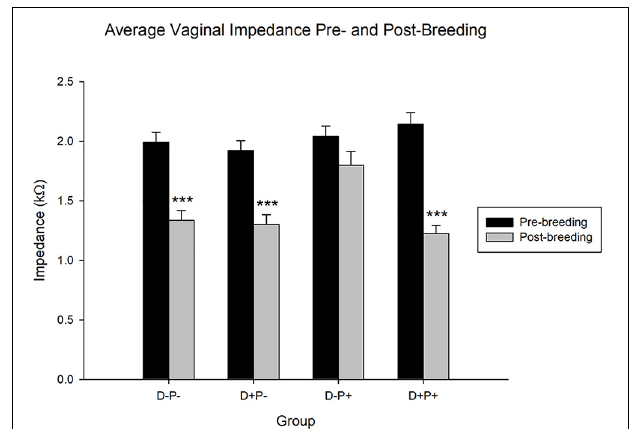
FIGURE 5 | Average vaginal impedance (k (cid:127) ) pre- and post-breeding. All groups with the exception of the D − P+ group showed a significant decrease in the average vaginal impedance over time. Data points include the impedance of rats from n = 19–21 rats/group for pre-breeding and n = 11–13 rats/group for post-breeding. Data is expressed as mean ± SEM. ∗∗∗ p < 0.001 (Relative to pre-breeding